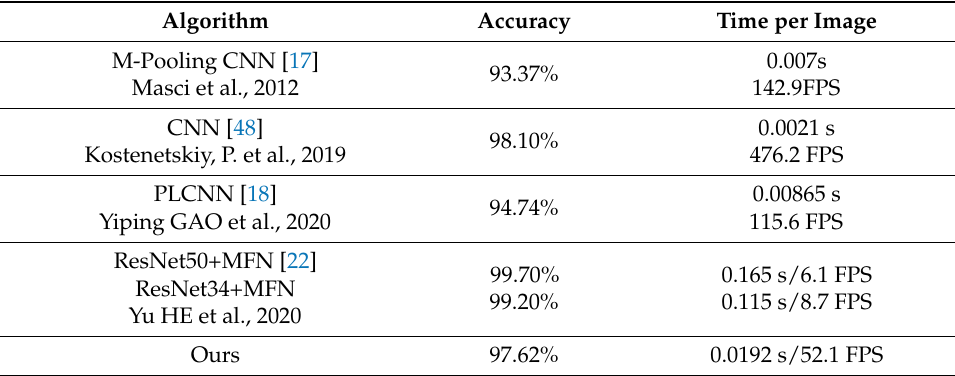
Table 4. DNN Algorithms tested on NEU